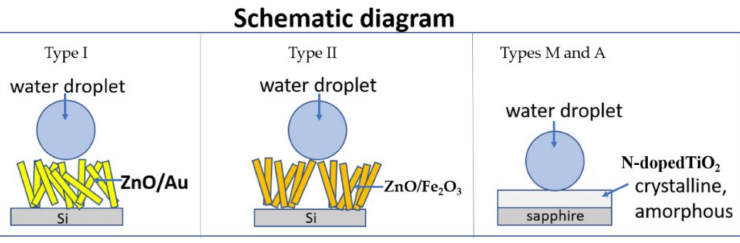
Figure 1. Schematic